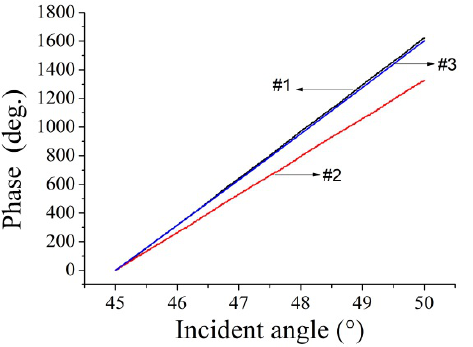
Figure 3. The phase versus the incident angle for the BBO plate scanning angle ranging from 45° to 50°.